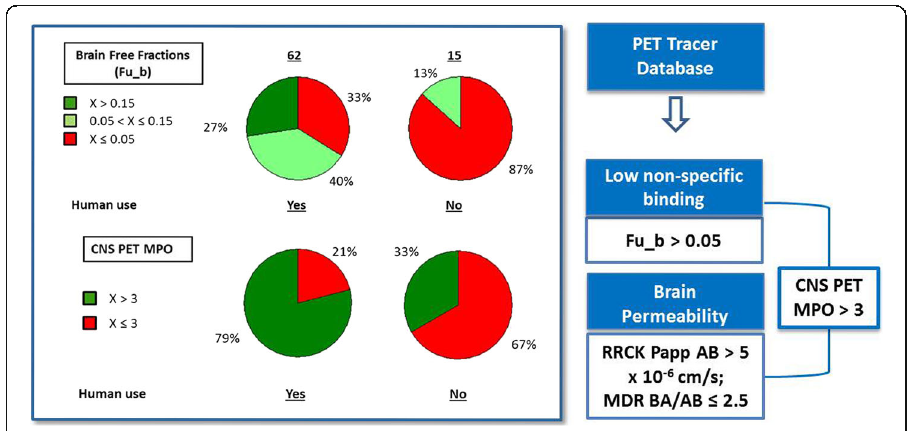
Fig. 3 CNS PET ligand design